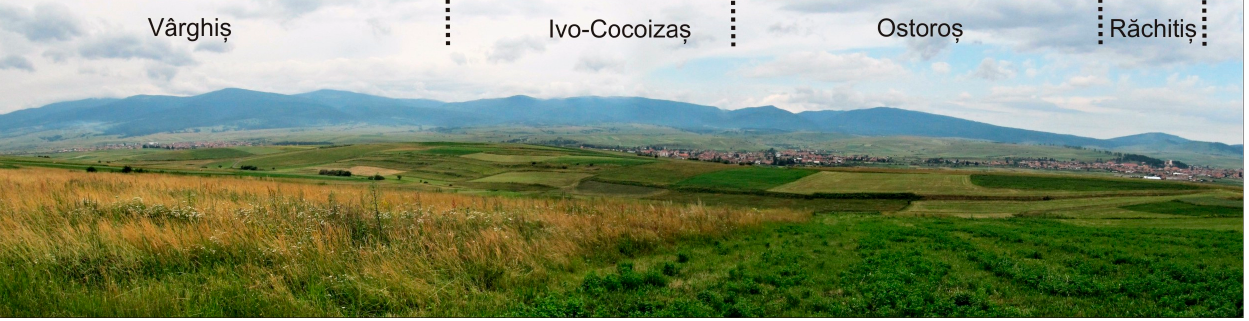
Figure 9. Panoramic view of the North Harghita Mountains, as seen from the East (Racu village) across the Middle Ciuc Basin. The volcanic edifices (from left to right, from South to North, respectively): Vârghis, Ivo-Cocoiza ș , Ostoro ș and R ă chiti ș . Note the shield-like profile of the Ivo-Cocoiza ș edifice. (Photo: Alexandru Szakács).